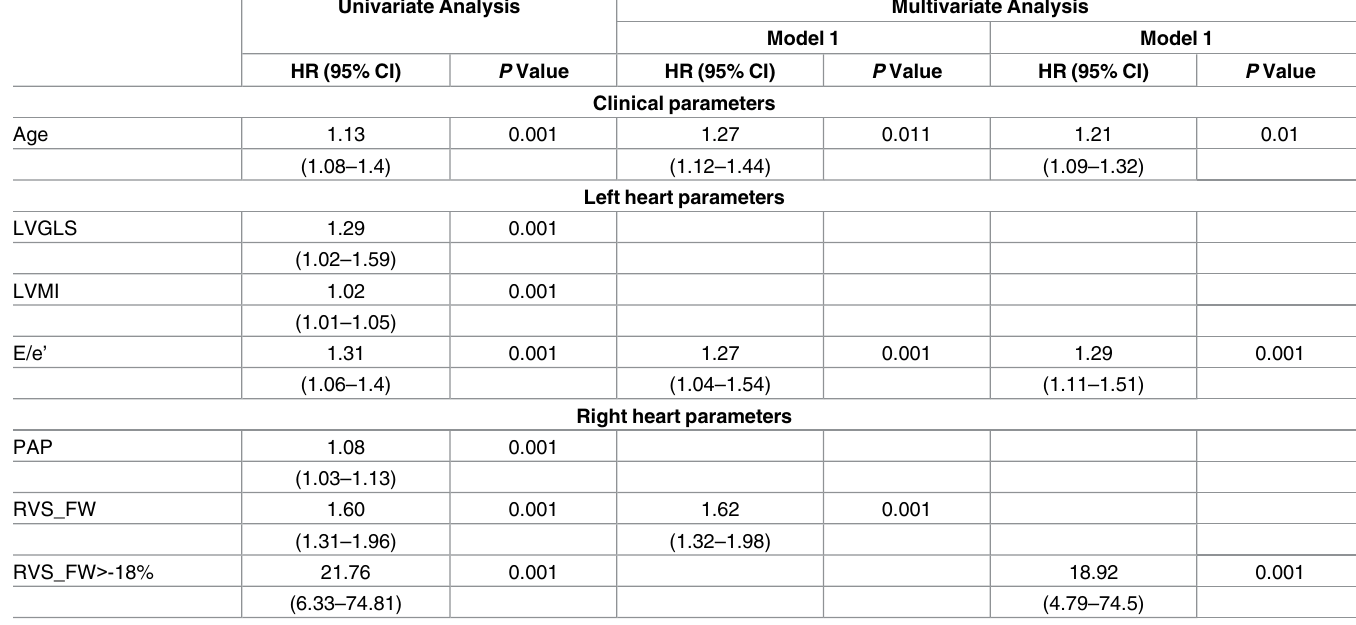
Table 3. Univariate and multivariate logistic regression of clinical and echocardiographic parameters in functional capacity with stepwise inclu- sion and